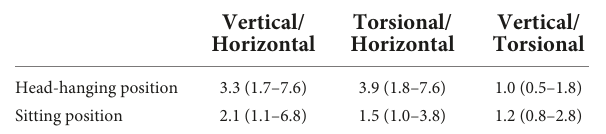
TABLE 5 The ratio of slow-phase velocity in the head-hanging position and sitting position of 84 patients with PSC-can.